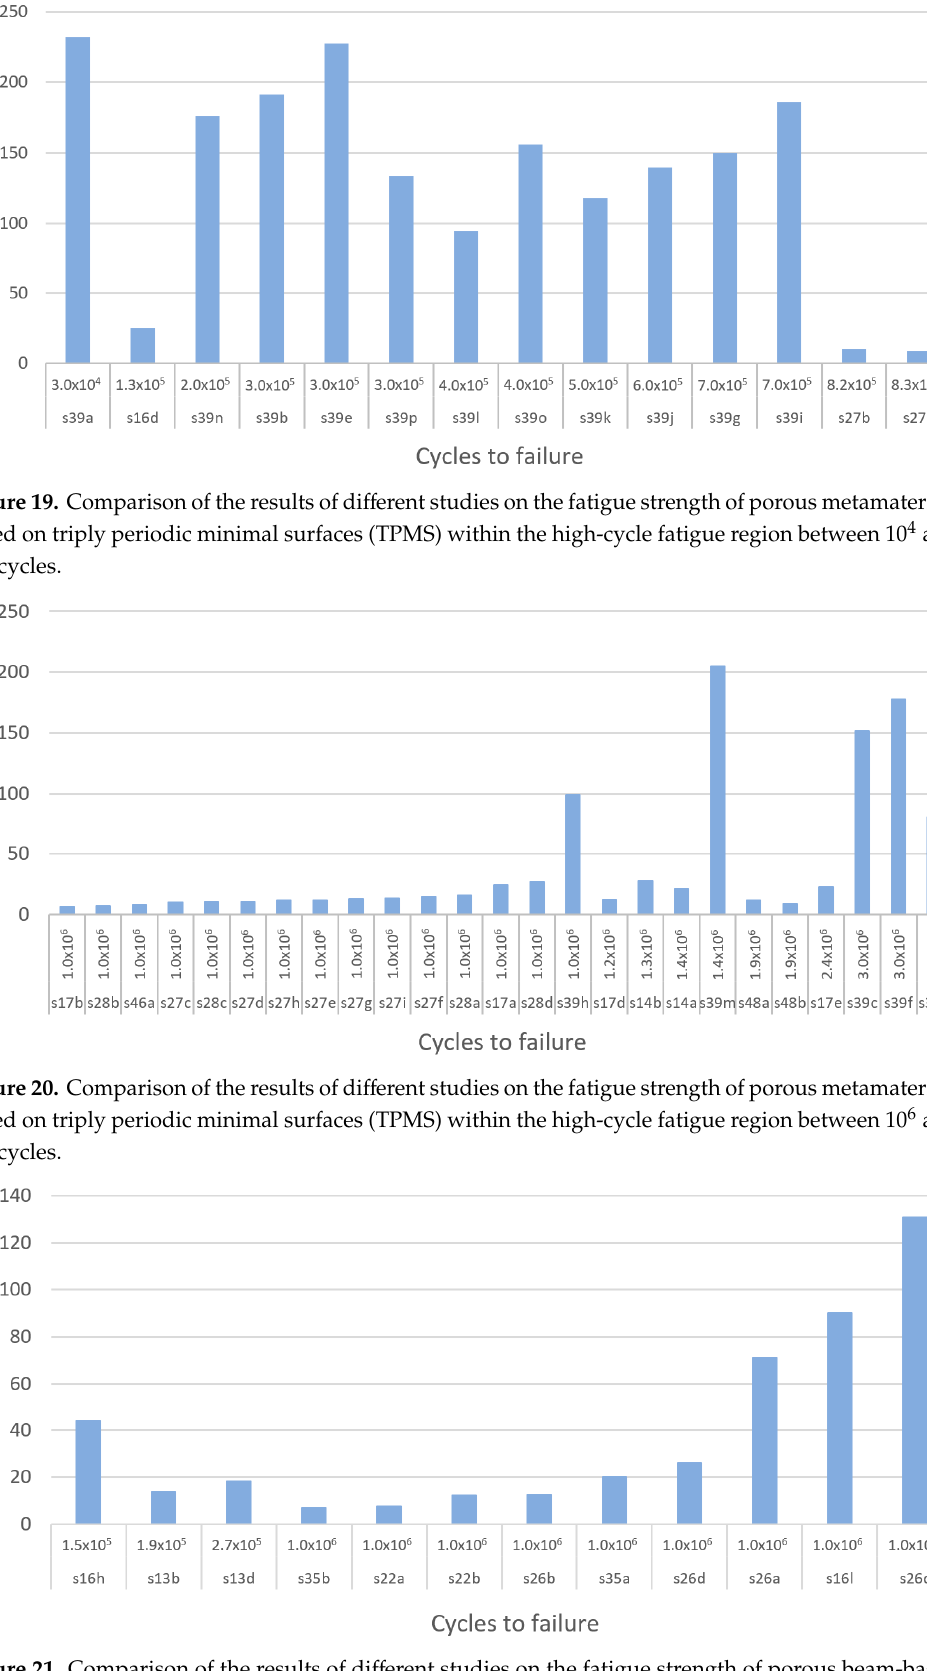
Figure 21. Comparison of the results of different studies on the fatigue strength of porous beam-based metamaterials within the high-cycle fatigue region between 10 6 and 10 7 cycles.